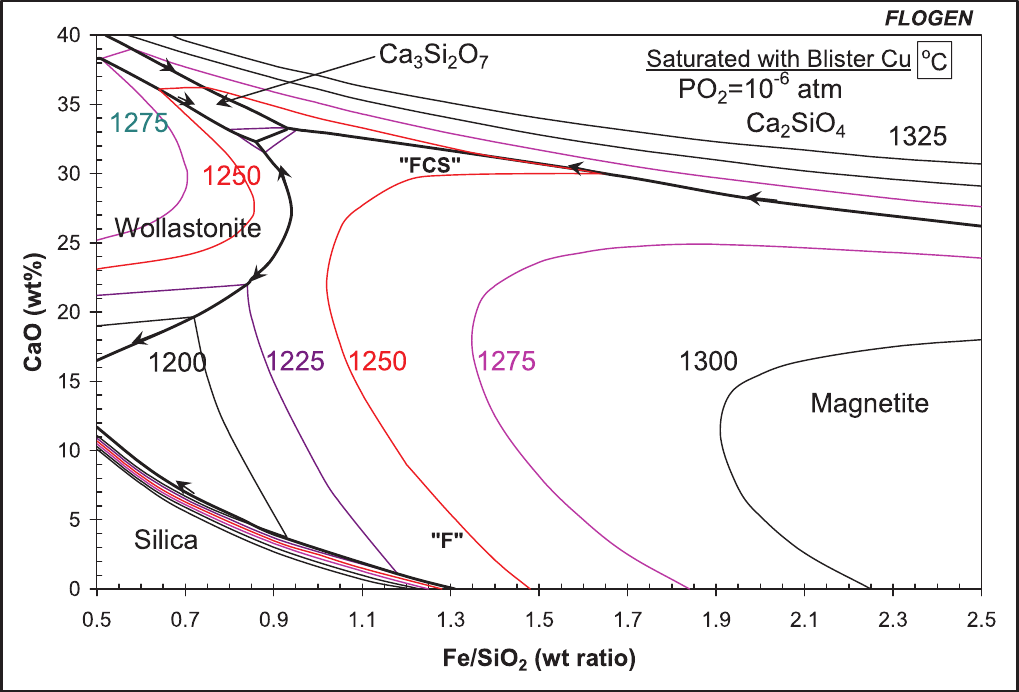
of 10 (cid:3) 6 atm. 2